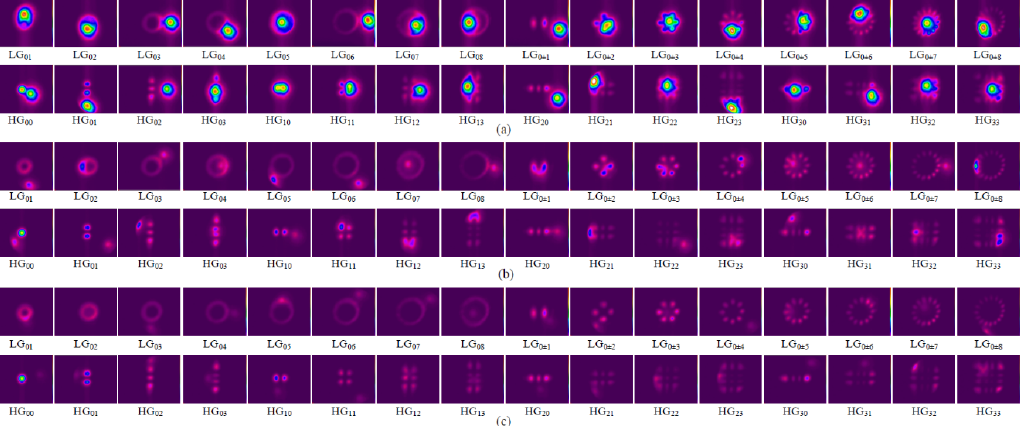
Figure 2. Measured beam profiles under jamming effect at SJRs of: ( a ) − 5 dB, ( b ) 0 dB, and ( c ) 3 dB. Reprinted from ref.